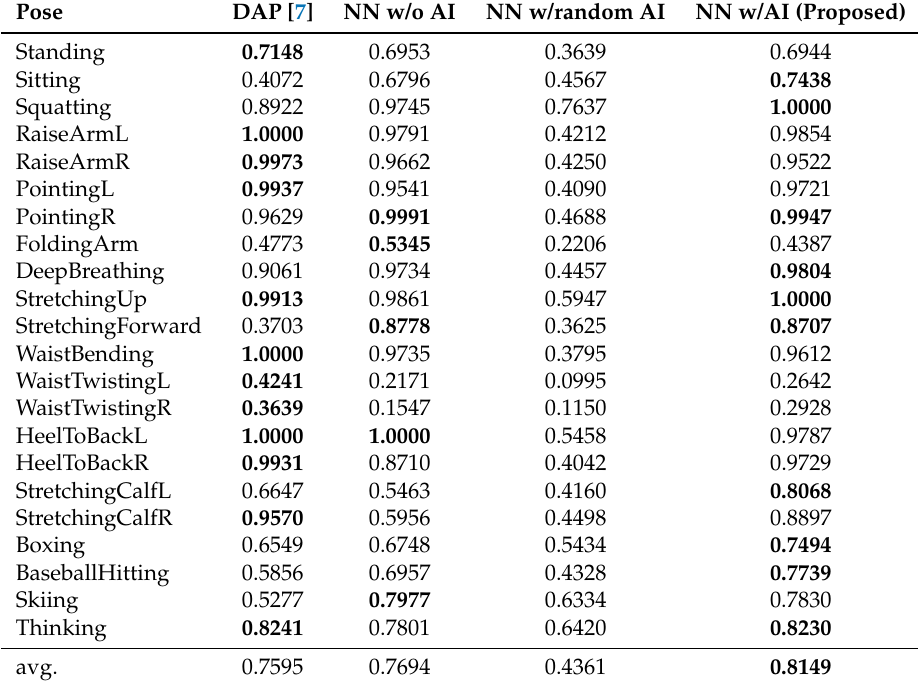
Table 5. The evaluation result (F-measure) of ZSL. Abbreviations are as follows. DAP: direct attribute prediction, NN: nearest neighbor, AI: attributes’ importance. The bold numbers represent the best score or the one close to the best (the difference is less than 0.01) for each